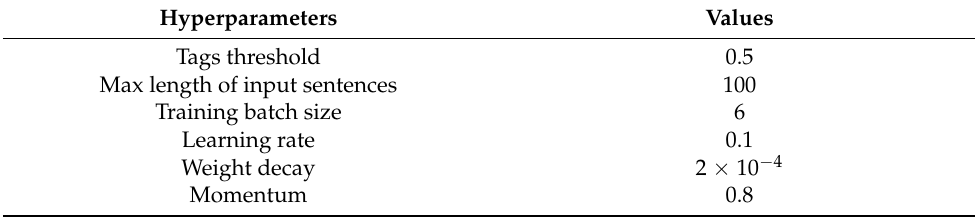
Table 3. Hyperparameters of the